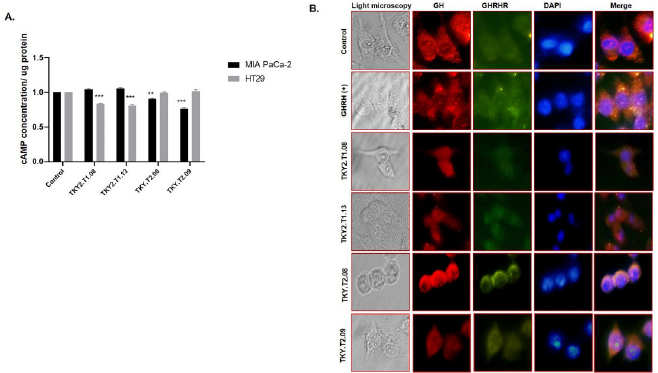
Fig 7. Blockage of GHRH signaling by selected aptamers. A. The effect of TKY2.T1.08, TKY2.T1.13, TKY.T2.08, TKY.T2.09 x-aptamers on the intracellular cAMP levels were determined by cAMP assay kit in both HT29 and MIA Paca-2 cells. B. The impact of TKY2.T1.08, TKY2.T1.13, TKY.T2.08, TKY.T2.09 x-aptamer on GH/GHRHR expression profile was investigated by co-immunofluorescence assay under a fluorescence microscope (Olympus). GHRH peptide (500 nM) was used as a positive control. Each experiment was performed and repeated at least two times, given figures are the representative figure of one of the three replicated assays. ns: non-specific, � p < 0.05, �� p < 0.01, ��� p < 0.001, ���� p <